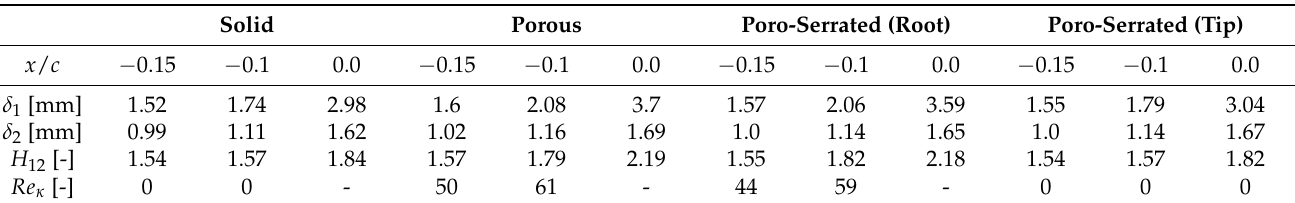
Table 1. Boundary layer parameters at three streamwise positions along the airfoil. The quantities are the displacement thickness δ 1 , the momentum thickness δ 2 , the shape factor H 12 , and the permeability Reynolds number Re κ .